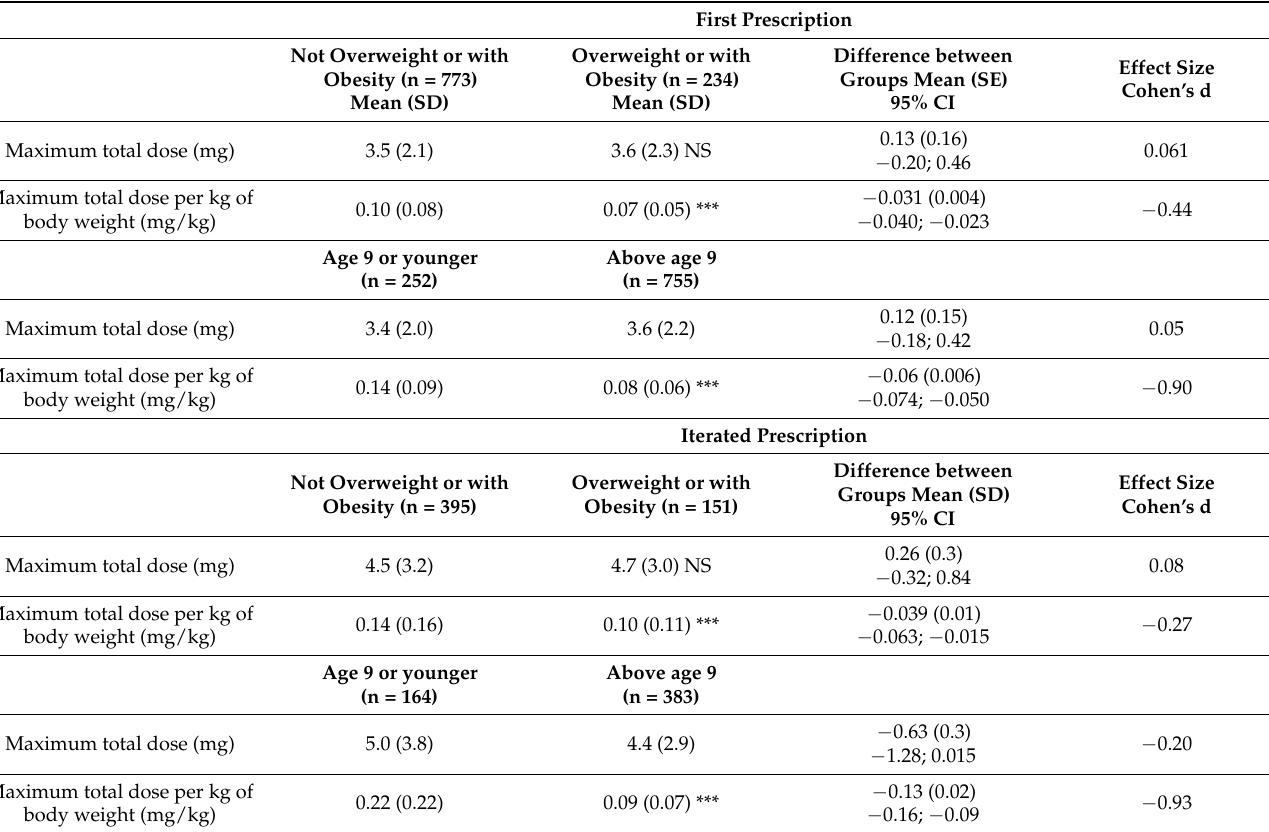
Table 2. Maximum prescribed melatonin total dose and dose per kg of body weight in relation to overweight or obesity and